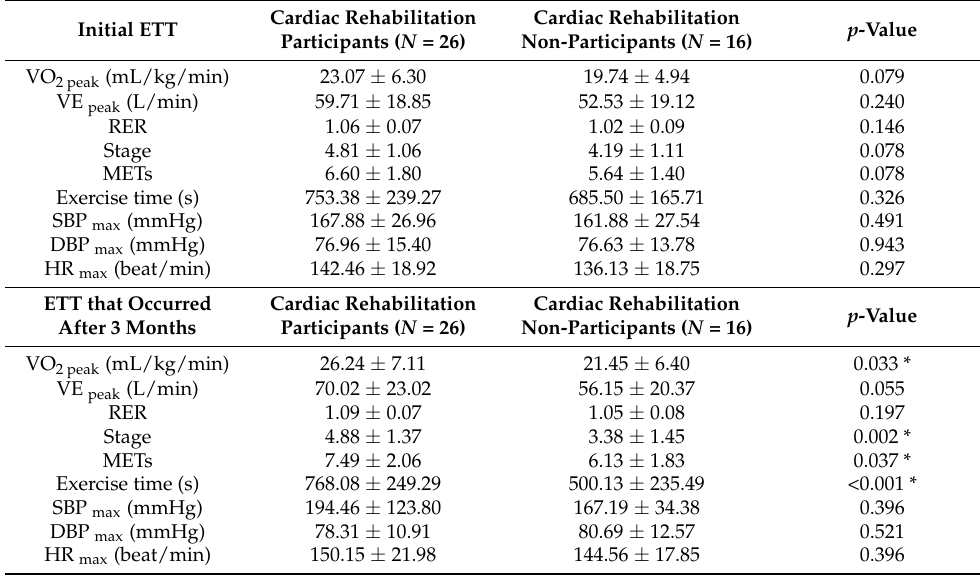
Table 2. Comparison of exercise capacity between CR participants and non-participants at initial and 3 months of